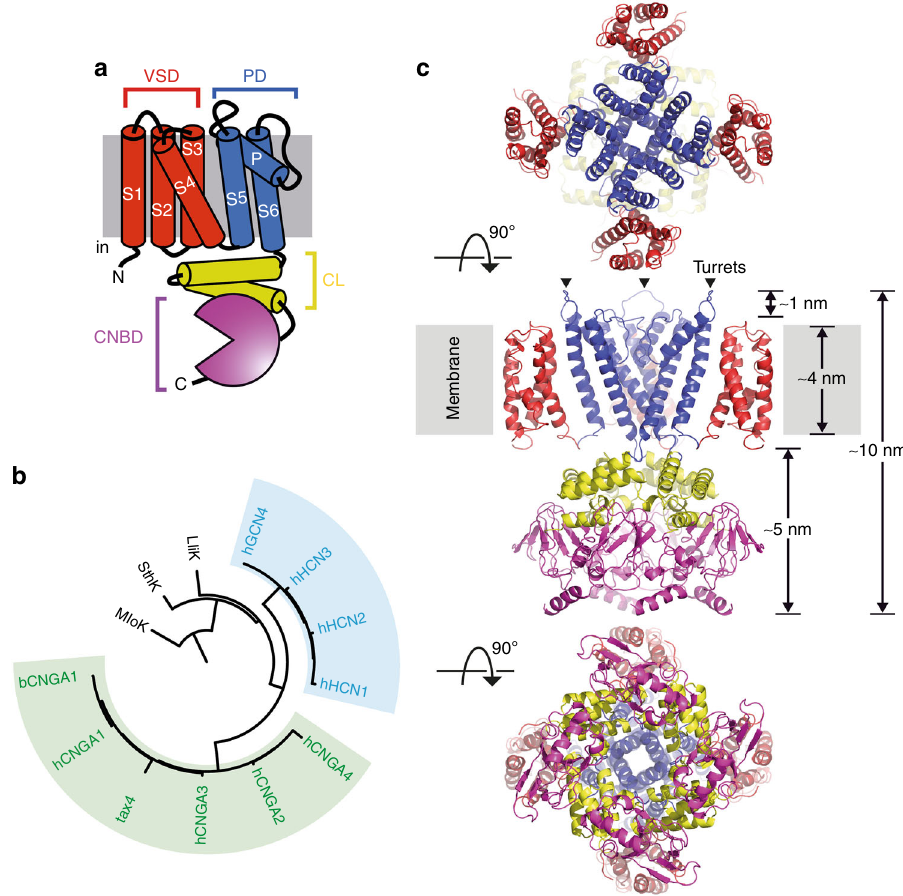
Fig. 1 SthK is a cyclic nucleotide-gated ion channel related to the CNG and the HCN subfamilies. a Cartoon of the topology of one subunit. The different functional domains are highlighted in colors: voltage sensor domain (VSD, red), pore domain (PD, blue), C-linker (CL, yellow), and cyclic nucleotide binding domain (CNBD, purple). b Phylogenetic tree of the CNGA (green) and HCN (blue) subfamilies. The prokaryotic CNG channels LliK and MloK1 (lacking the CL), of which the structures are known, are shown for comparison. c High-resolution cryo-EM structure of the SthK resting state (PDB 6CJQ) viewed from the extracellular (top), membrane plane (middle), and intracellular (bottom) side. The functional domains are color-coded as in a . Turrets are highlighted by arrowheads. For clarity, the VSD and PD domains of the protomer nearer to the viewer have been omitted in the membrane plane